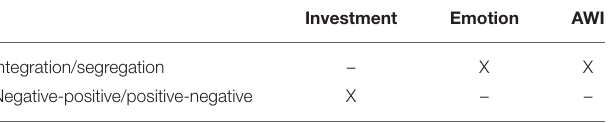
TABLE 4 | Summary of statistical results for the information scenario BP/SN.